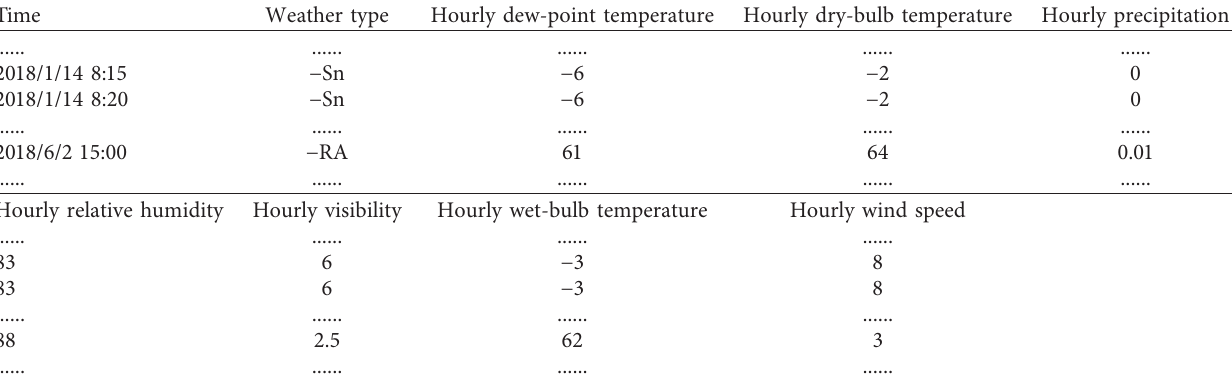
Table 2: Weather dataset